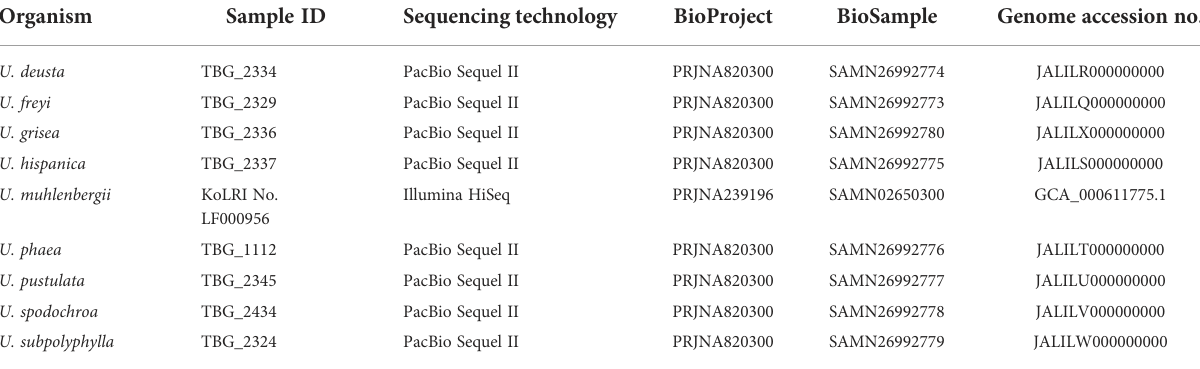
TABLE 1 Voucher information of the genomes used in the